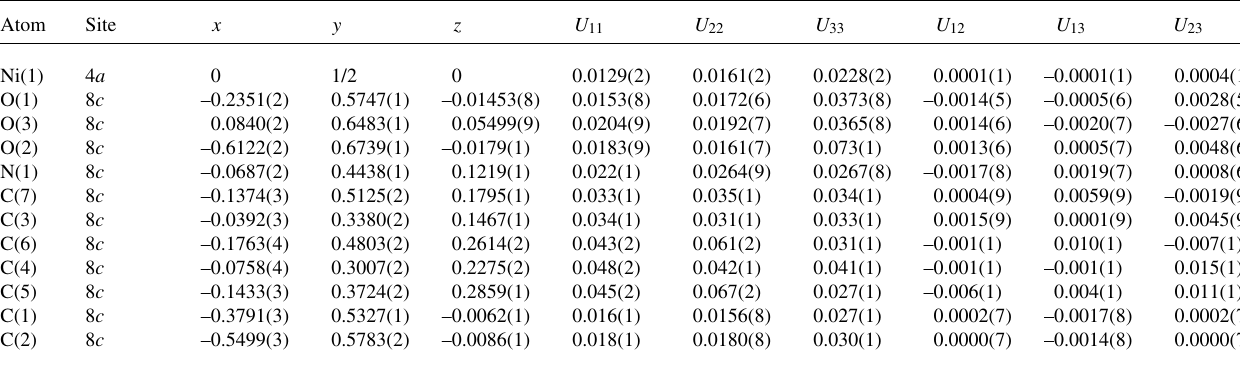
Table 3. Atomic coordinates and displacement parameters (in Å 2 )